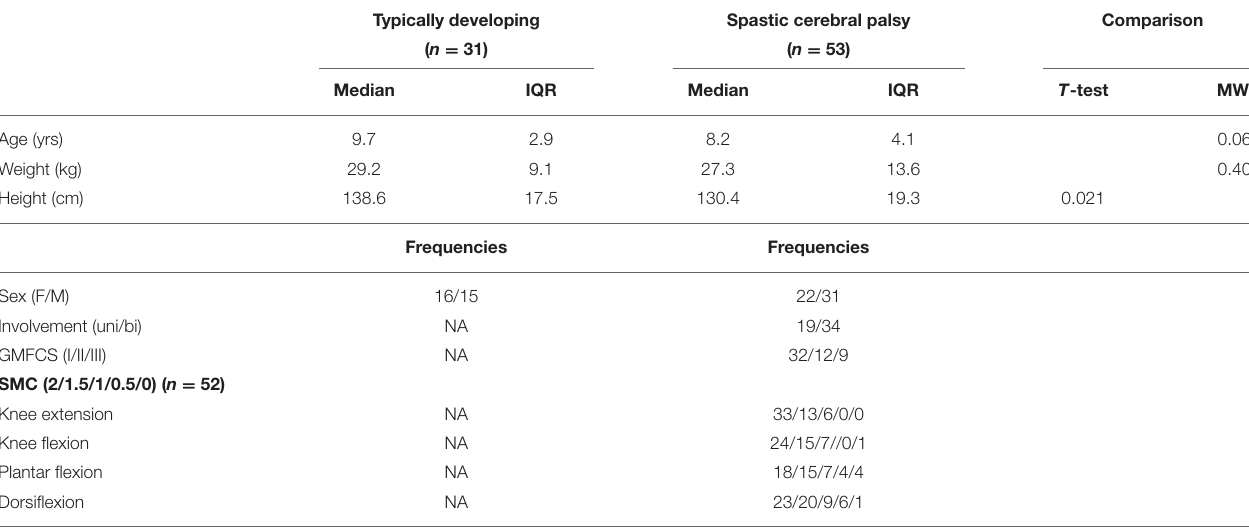
TABLE 1 | Participant